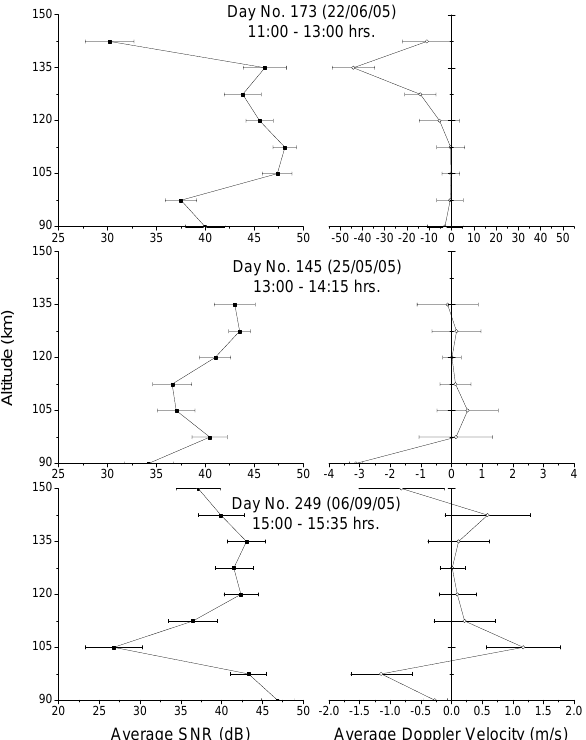
Fig. 7a. Altitude versus average SNR (left panels) and Doppler velocity (DV) (right panels) of individual E S occurrences on 173, 145 and 249.